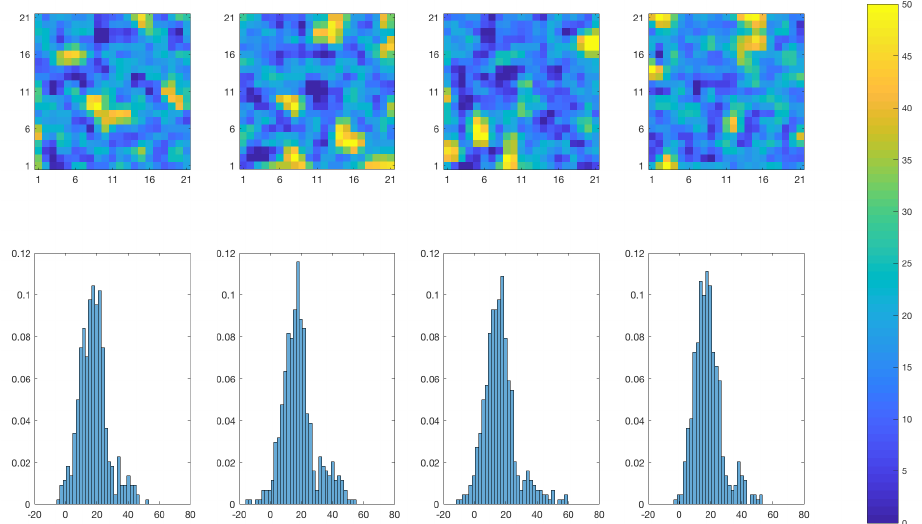
Figure 15. Realizations from the selection-Gaussian initial distribution of the initial temperature field f ( r 0 ) at time T = 0 (upper panels) and associated spatial histogram (lower panels). Upper panels: the colorbar gives the temperature in ◦ C. Lower panels: the horizontal axes represent the temperature ( ◦ C), the vertical axes represent the relative prevalence of each temperature value for the realization right above.